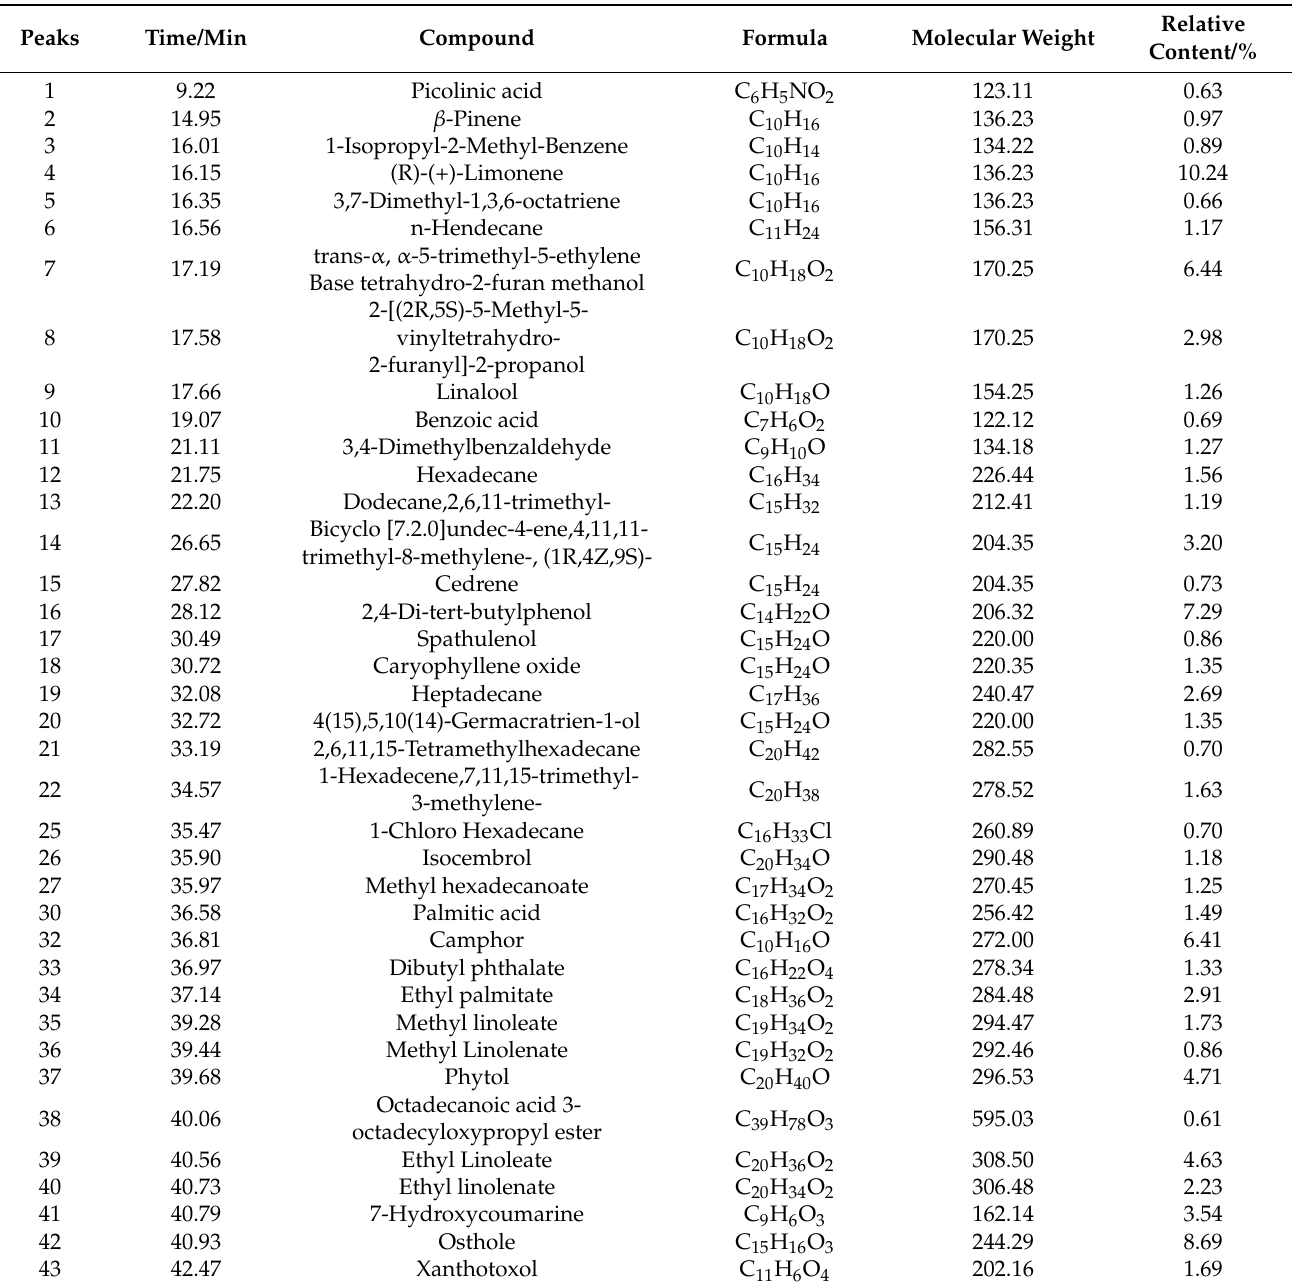
Table 1. Chemical composition of IPF essential